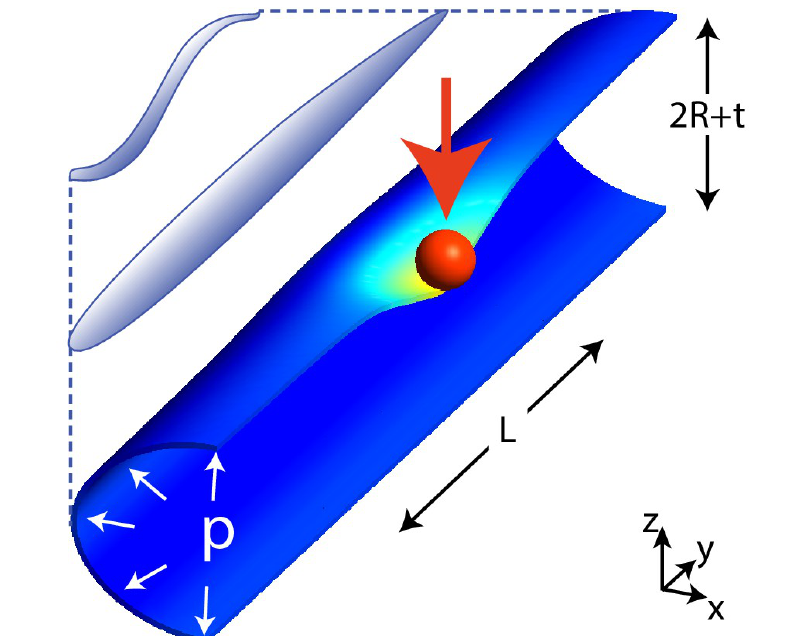
Figure 10. Schematic representation of C. elegans body and mechanics. A cylindrical shell 1 mm long and with a radius of about 25 µ m is used. Such a shell is indented by the application of a spherical bead. The symbol t denotes the thickness of the shell. Reproduced from [223] under the CC BY